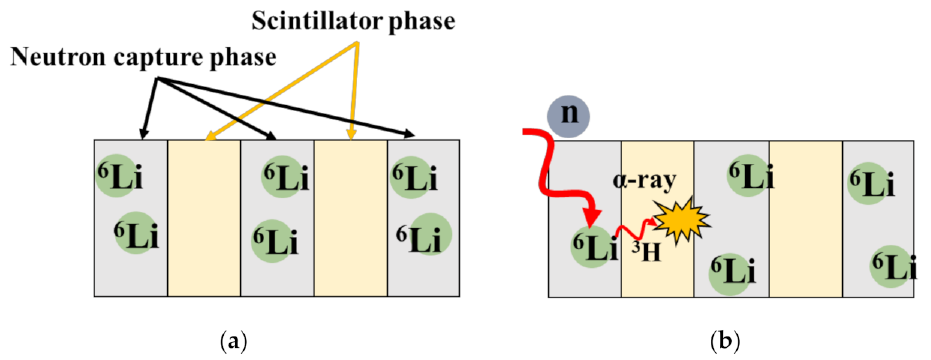
Figure 1. Schematic diagrams of ( a ) a eutectic scintillator for thermal neutron detection and ( b ) luminescence